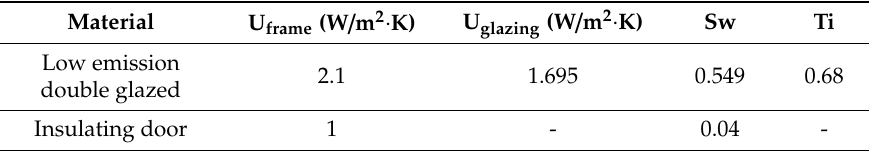
Table 2. Haracteristics of the